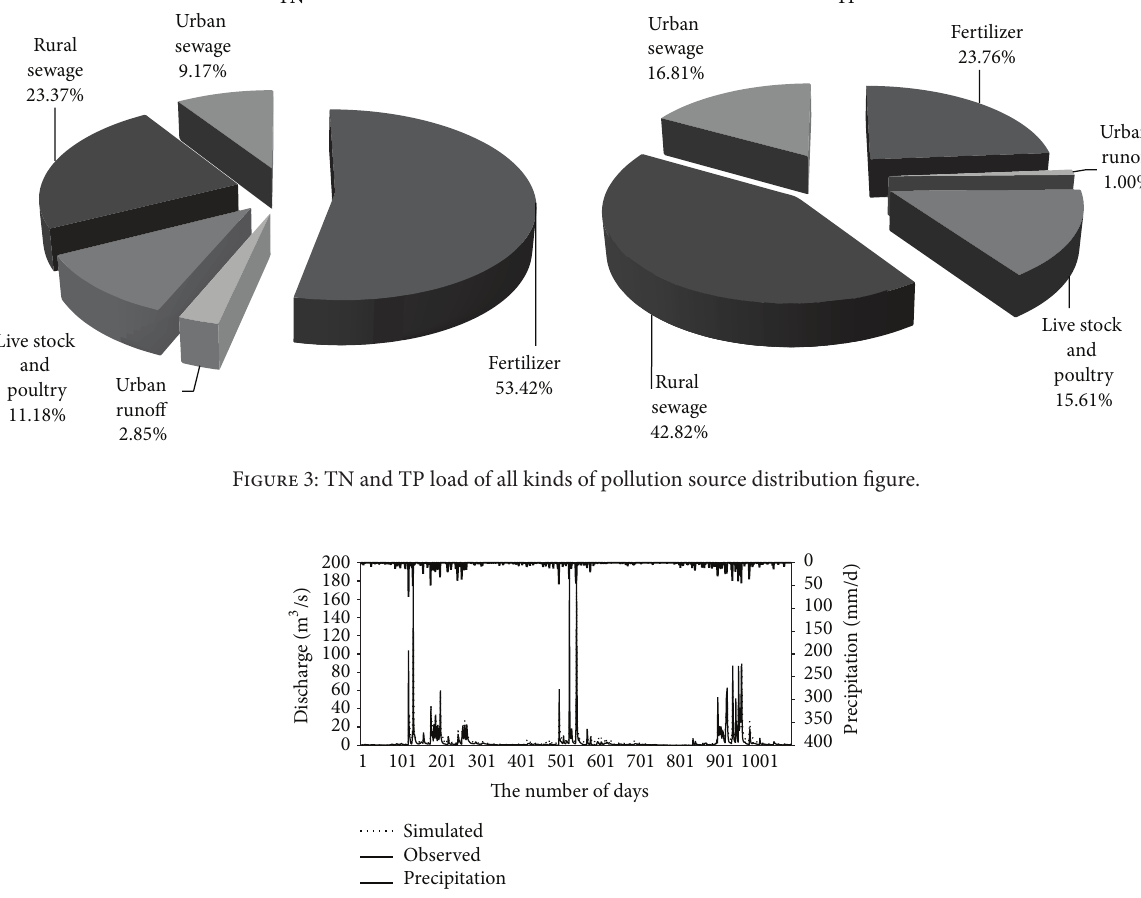
Figure 4: Calibration and validation results in Lizixi River basin: observed and simulated daily hydrographs.